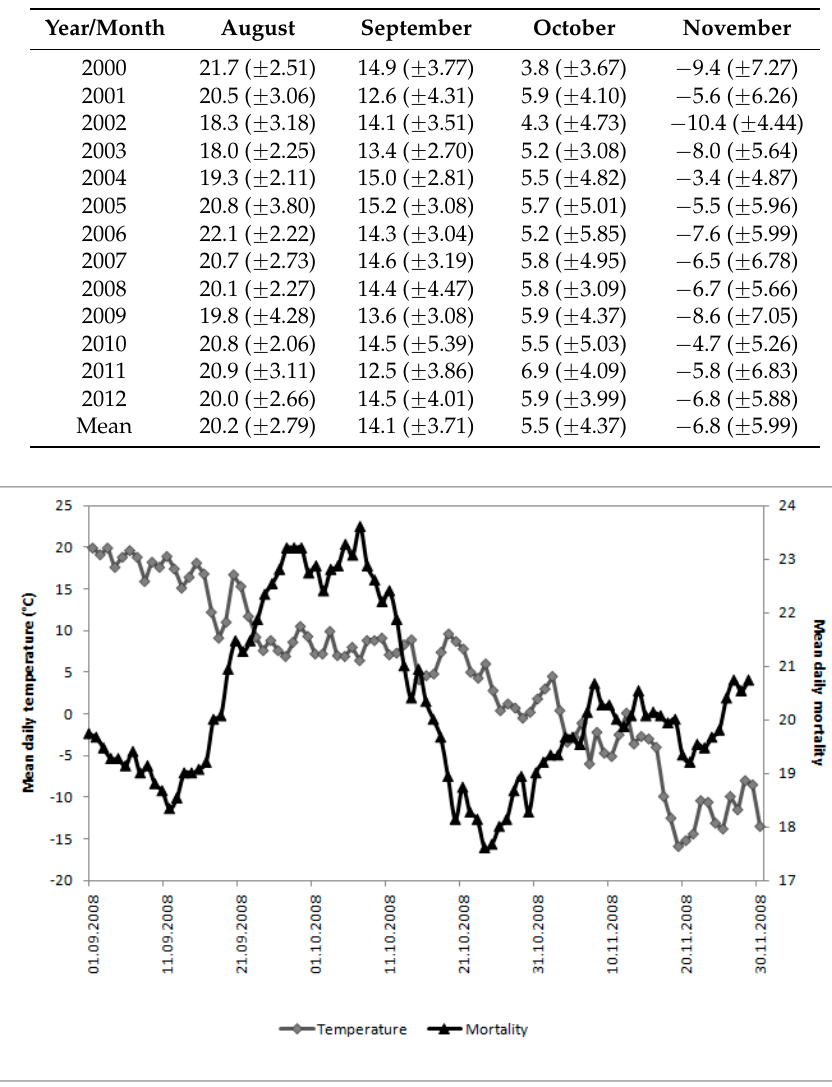
Figure 5. Mean daily temperature and 15-day running mean of daily mortality for Khabarovsk over the autumn of 2008 (1 September to 30 November).